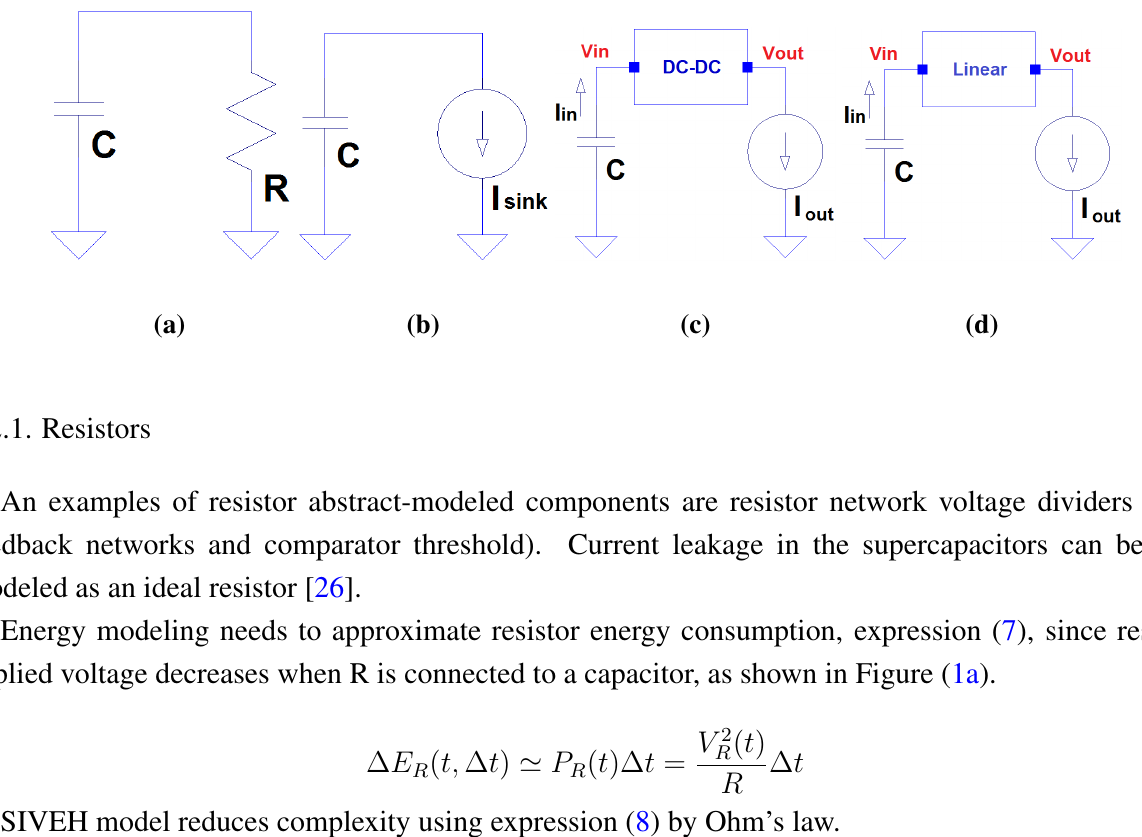
Figure 1. Energy harvesting circuit basic blocks: (a) resistor, (b) current sink, (c) DC-DC converter and (d) linear